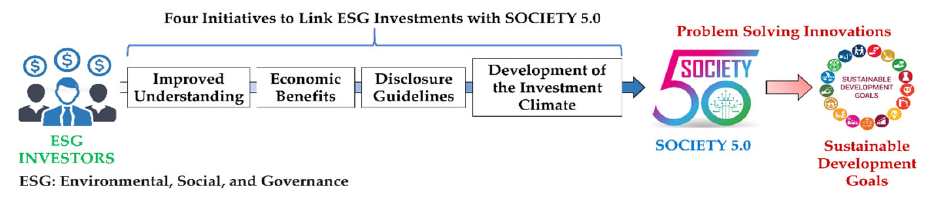
Figure 9. Initiatives to Link ESG Investments with Society 5.0.